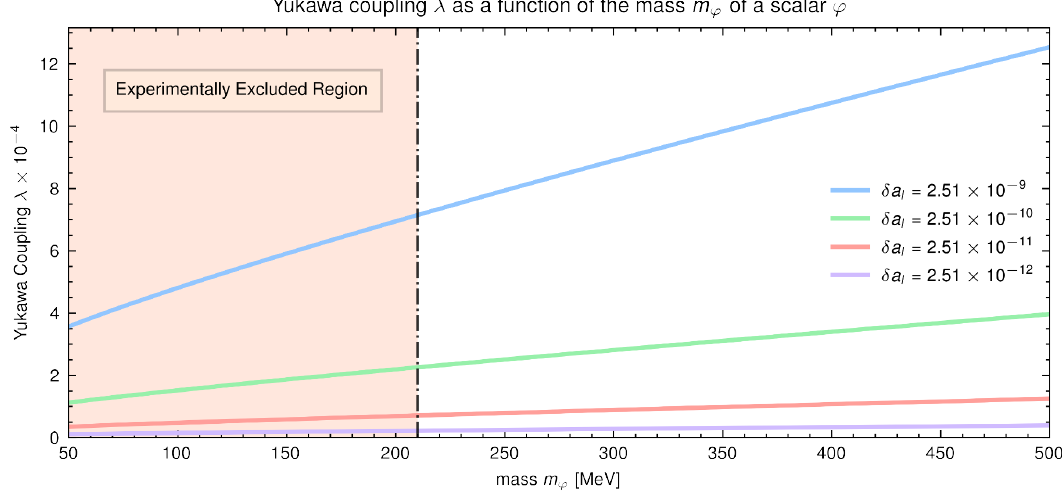
Figure 5 . Plots of the Yukawa coupling λ µ between the muon and a given scalar ϕ , as a function of the scalar mass m ϕ , in order for the 1-loop contribution to the δa µ to be 2 . 5 (10 − 9 , 10 − 10 , 10 − 11 , 10 − 12 ) ×